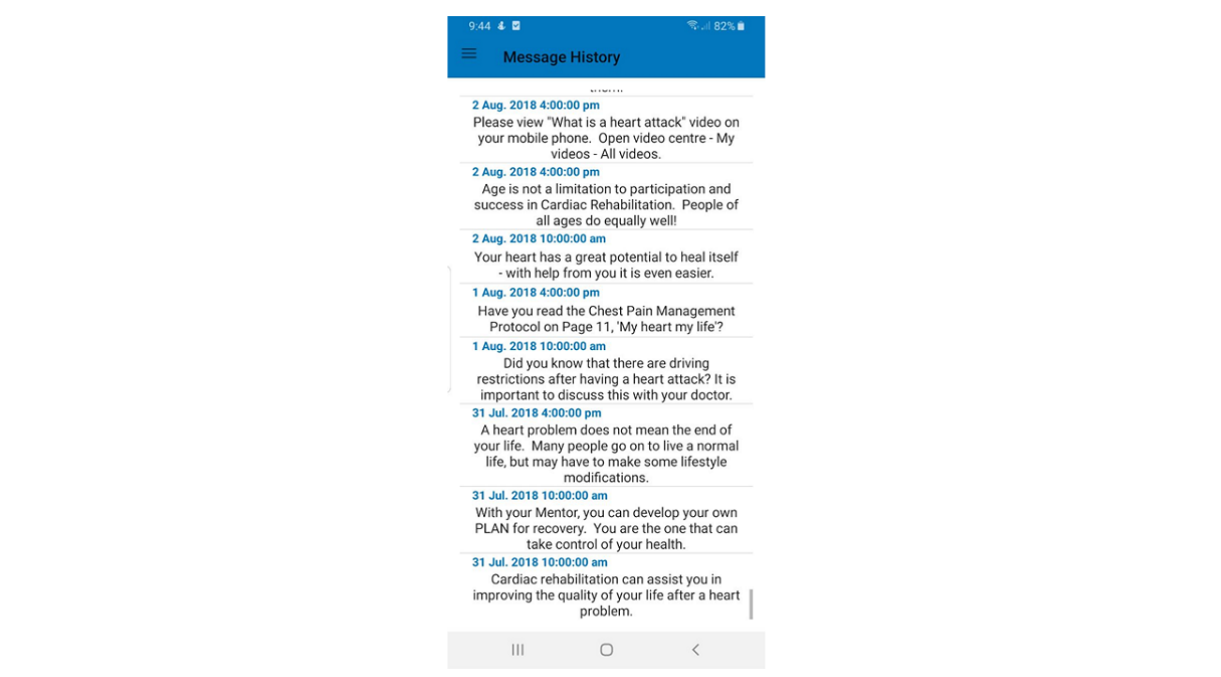
Figure 7. Motivational